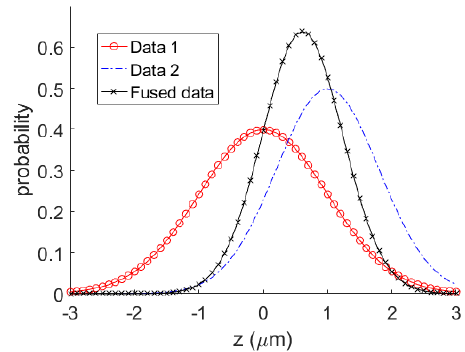
Figure 2. Fusion of two Gaussian distributions.